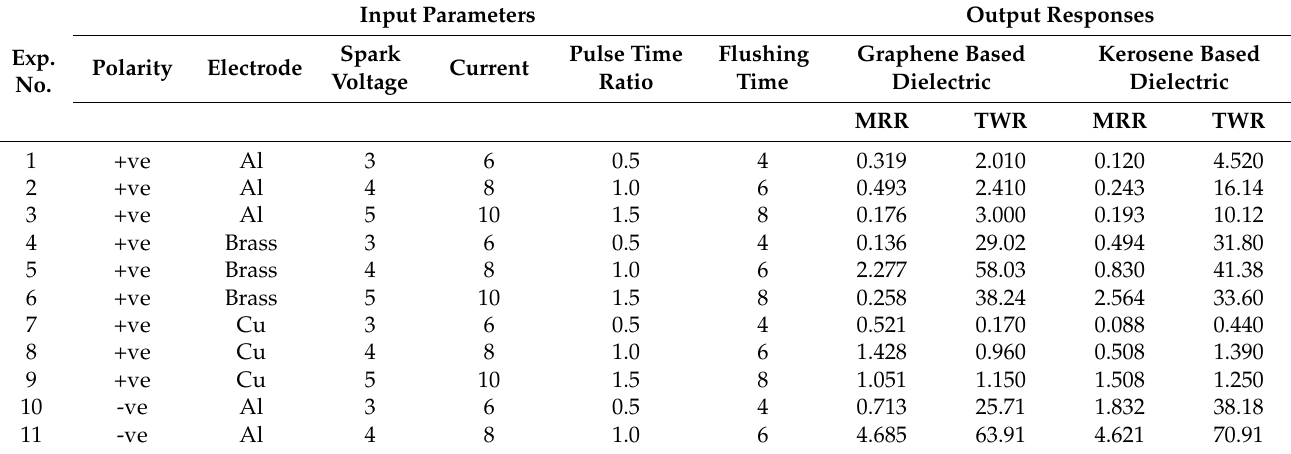
Table 5. Input parameters and output responses for graphene and kerosene-based dielectric.